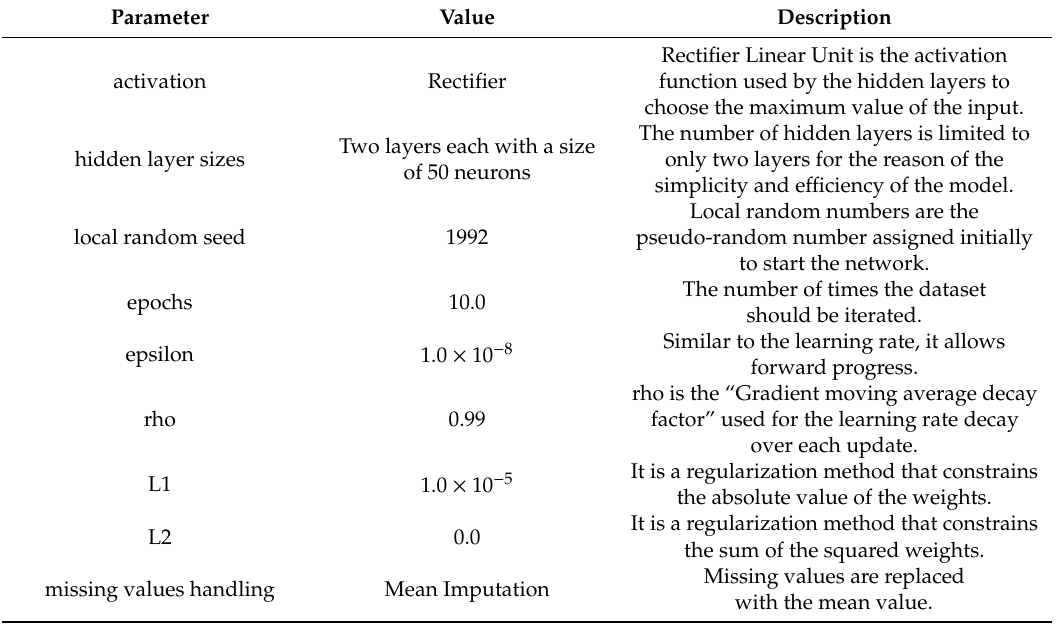
Table 1. Parameter settings of the proposed deep learning (multi-layer perception (MLP)) classification model.